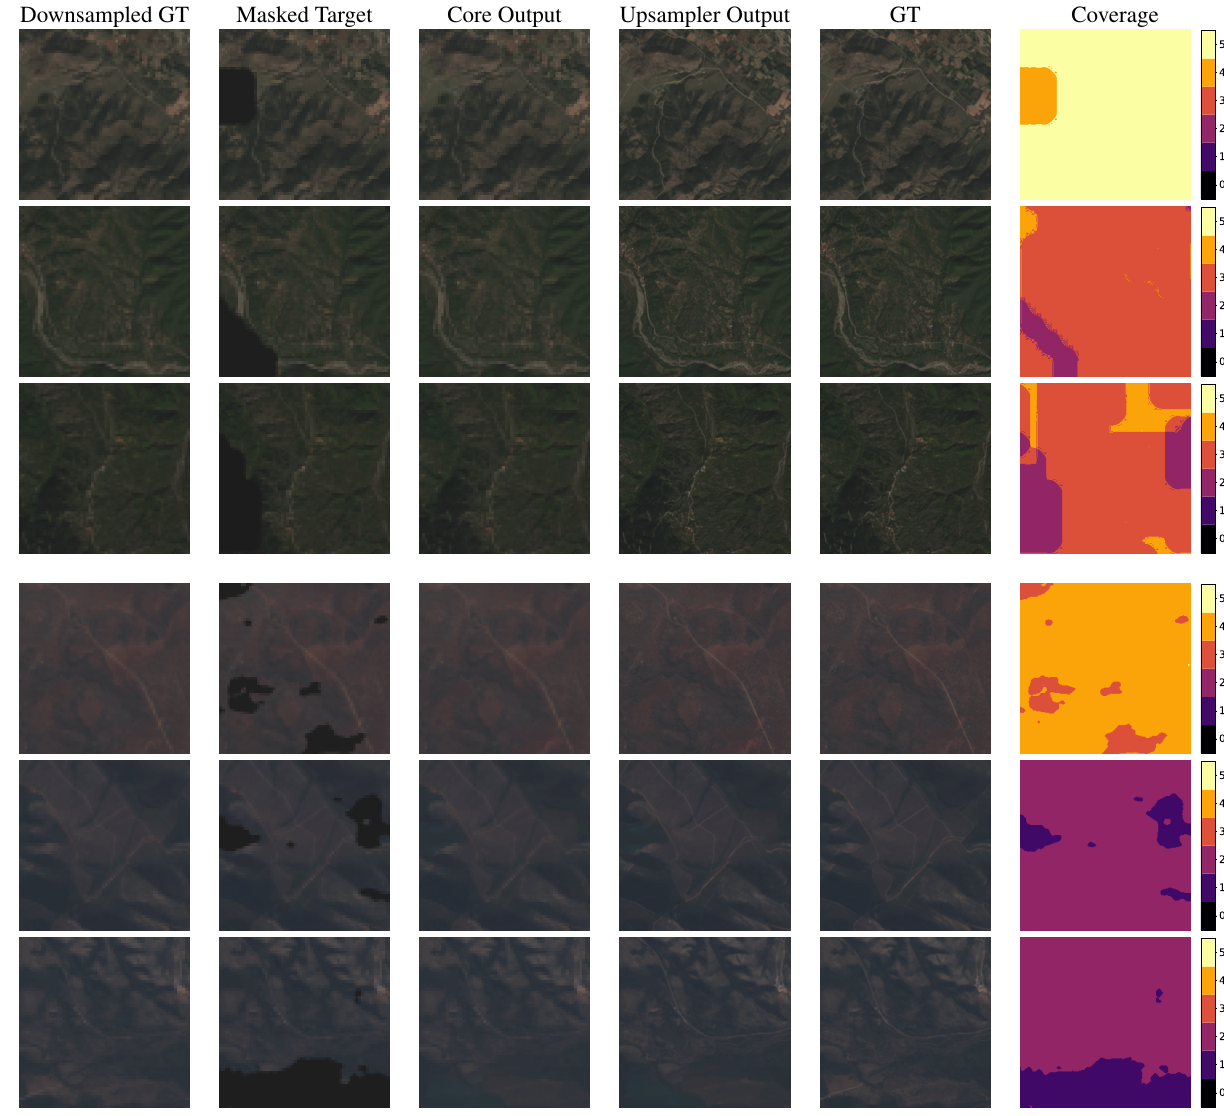
Figure 3. Random samples from validation set of our dataset (top three rows) and SEN12MS-CR-TS (bottom three rows). (Best viewed on screen zoomed-in)